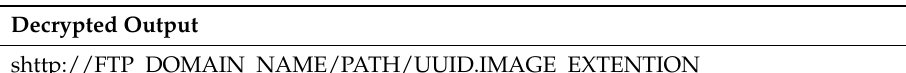
Table A9. Decrypted